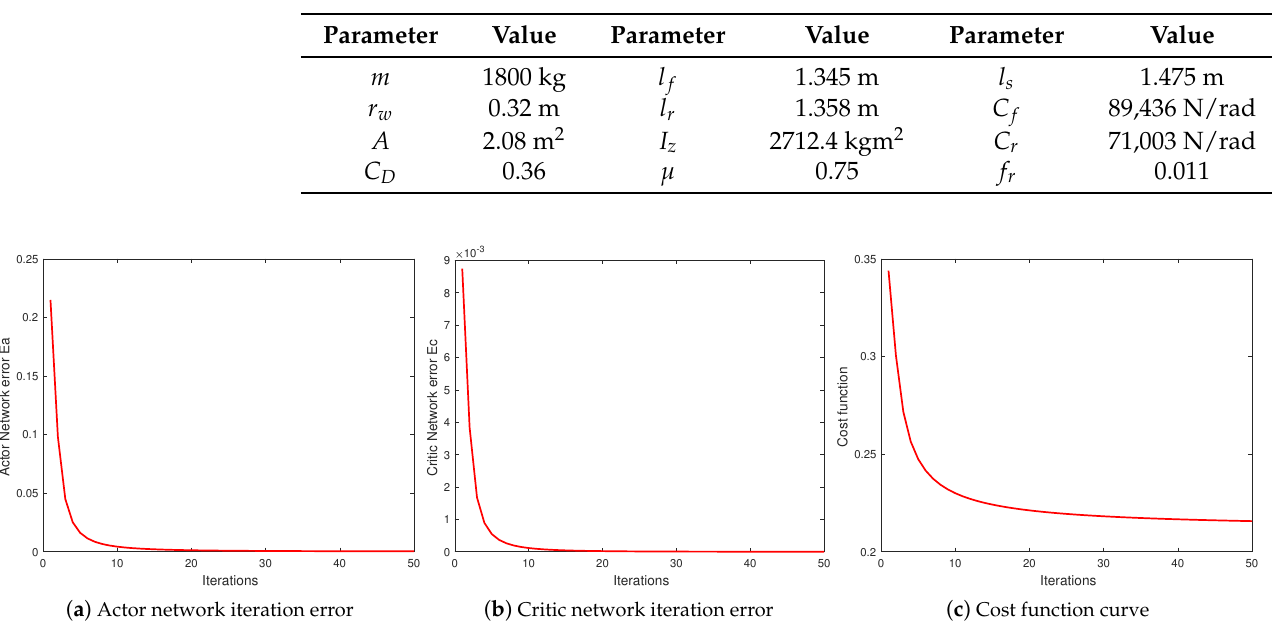
Figure 5. Intelligent connected vehicle HIL experimental platform. Table 1. Parameters.